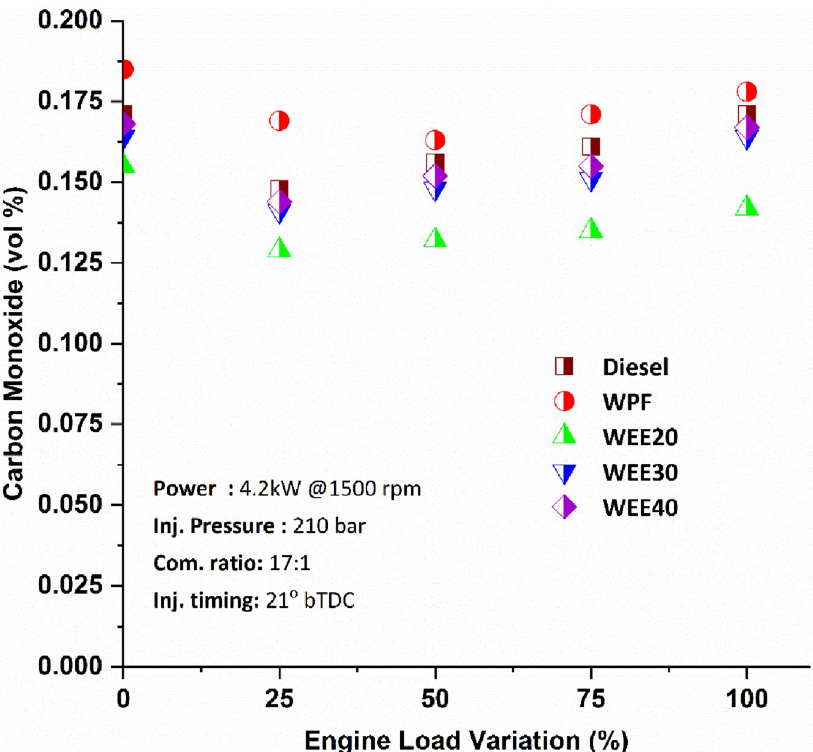
Figure 5. Variation of Carbon monoxide emissions on engine loads.